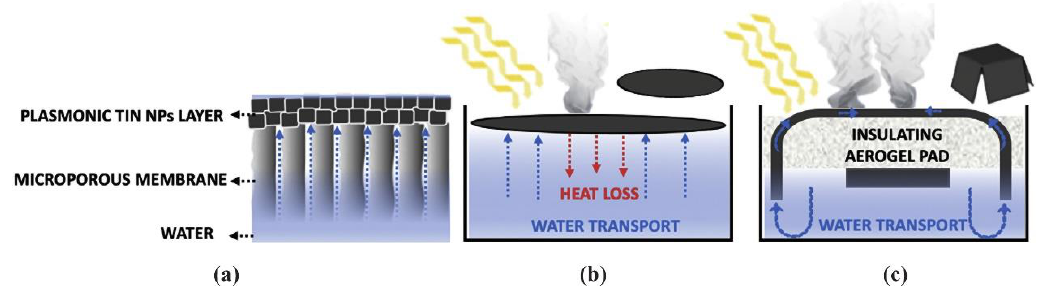
Figure 5. The experimentally studied systems by Farid et al.: ( a ) transport of water through the microporous channels of the membrane to the surface where plasmonic NPs are placed; ( b ) evapo- ration of water on the surface of the membrane due to the heat generated by plasmonic NPs in a non-insulated system; and ( c ) insulating the system using an aerogel pad to reduce the heat loss for enhancing vapor generation. Reprinted with permission from [98] . Copyright © 2020, Elsevier.